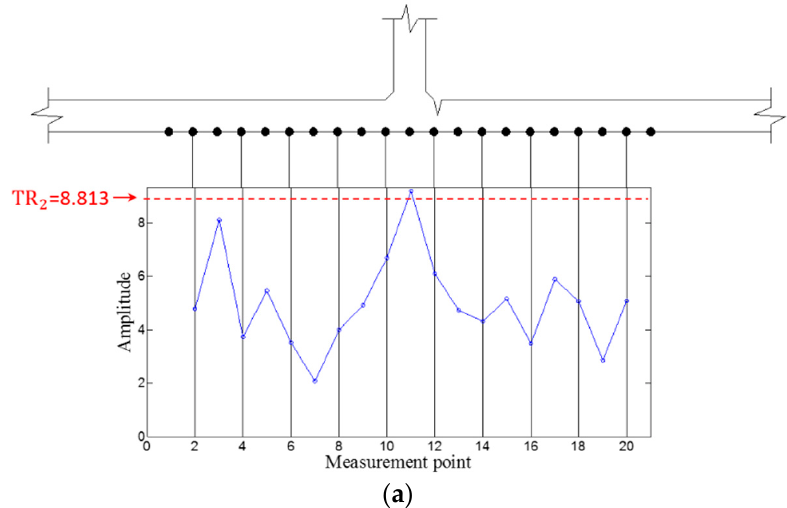
Figure 18. ZLCC values obtained from the intact area at 100 kHz ( a ) before and ( b ) after applying TR 2 . Sensors 2016 , 16 , 1511